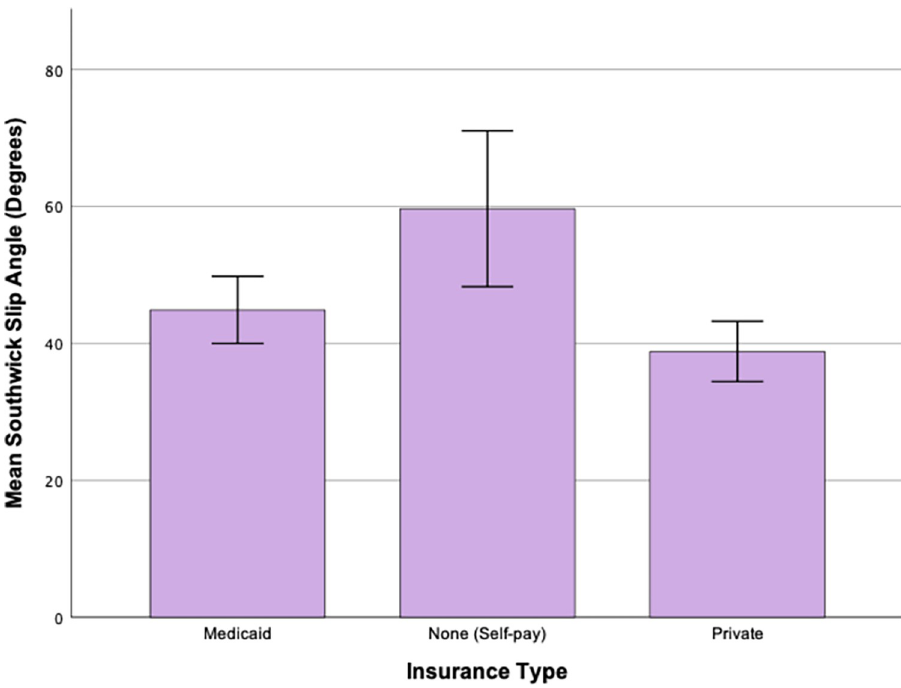
Fig 1. Southwick slip angle mean separated by insurance type. Error bars represent 95% confidence